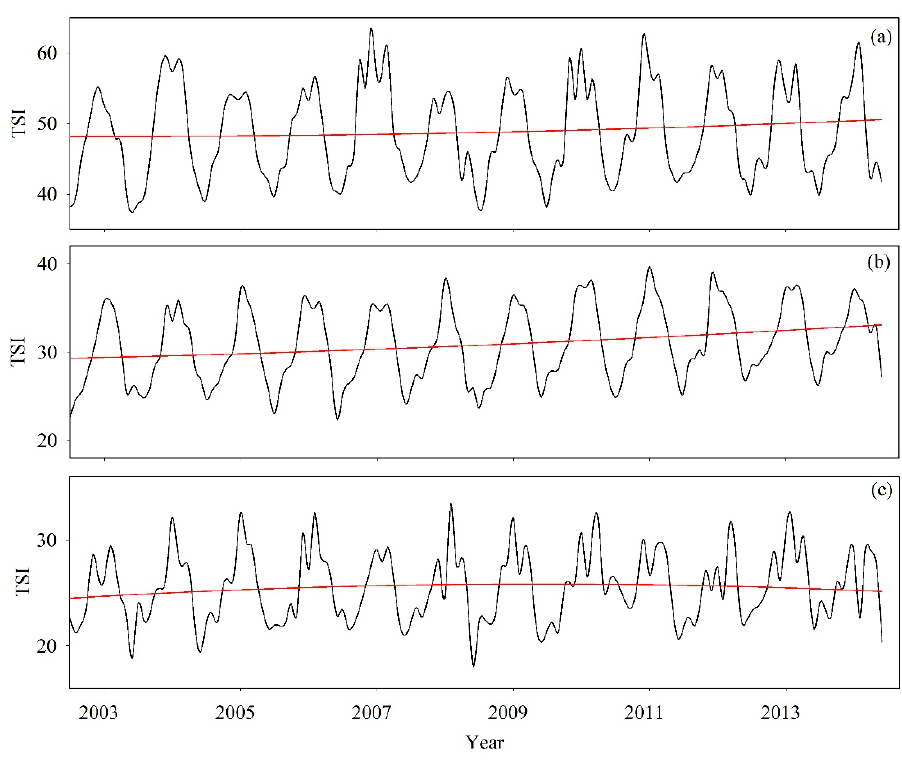
Figure 9. Changing trend of TSI in the CECZ seas during 2002–2014: ( a ) Bohai Sea, ( b ) Yellow Sea, and ( c ) East China Sea. Monthly mean TSI were derived from the MODIS monthly mean R rs data. All data within R rs (555) > 0.0 sr − 1 were included in the analysis. The black line was the original data, while the red line was the changing trends extracted using Hilbert-Huang transform proposed by Huang et al. [33].